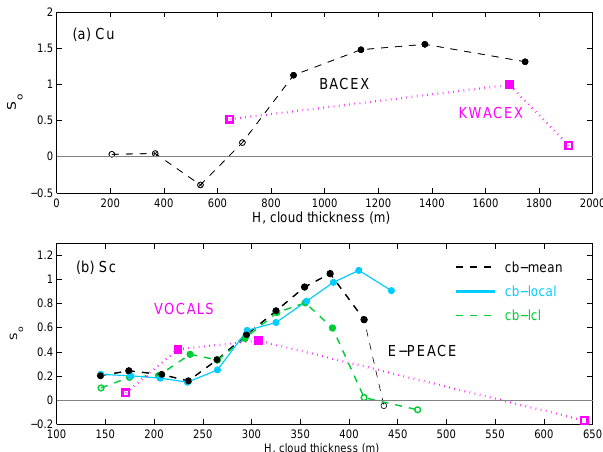
Figure 4. Precipitation susceptibility, S o , estimated with aircraft measurements for (a) Cu (12 flights of BACEX and 4 flights of KWACEX) and (b) Sc (13 flights of E-PEACE and VOCALS-REx). E-PEACE S o is estimated from (i) the cloud-base height, which is identified using LCLs (cb-lcl) and (ii) from the vertical structures of LWCs (lowest height where the vertical gradient of LWC is the greatest) as the aircraft enters the cloud deck to conduct the cloud- base level-leg flight (cb-local), and (iii) from the averaged cloud- base heights from the nearby soundings and cb-local (cb-mean). Filled circles are statistically significant at 99% confidence level. The number of data points used for S o estimates and their statistical significance are shown in Table